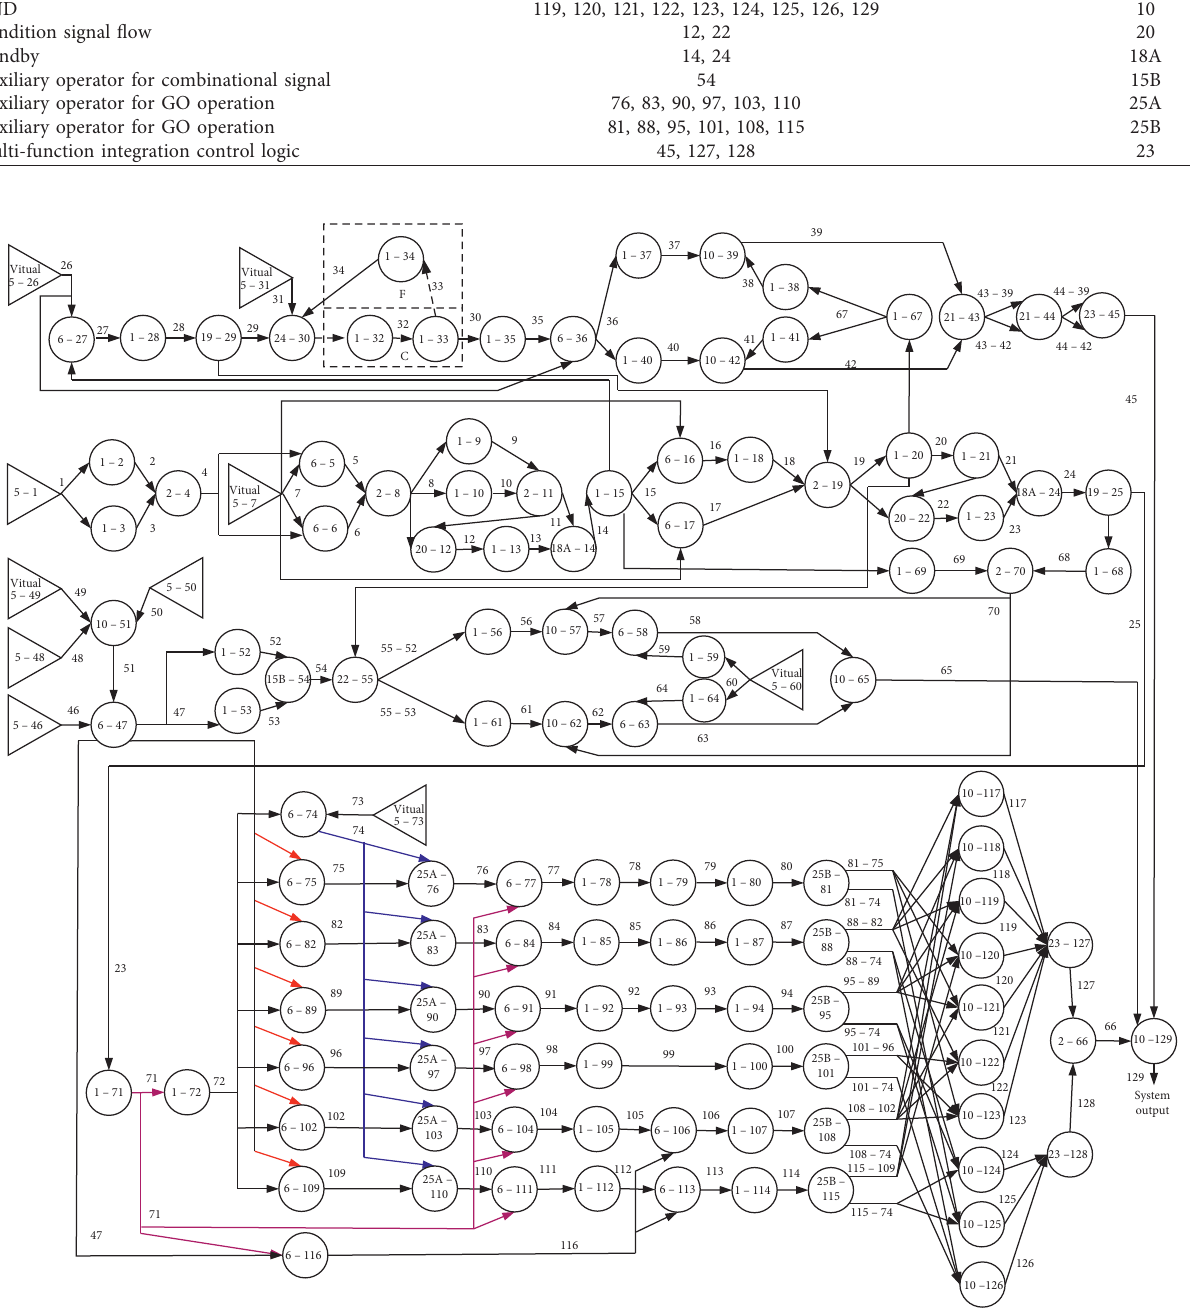
Figure 14: GO model of